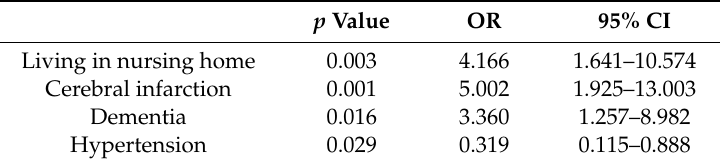
Table 4. Characteristic factors associated with AsP in a logistic regression analysis. p Value OR 95%